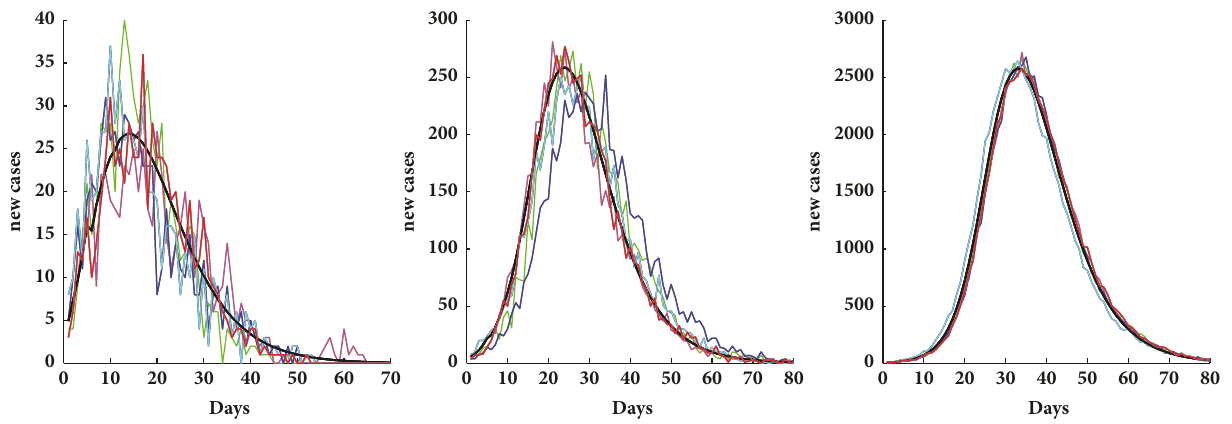
Figure 1: Three realizations are plotted for three values of 𝑁 ( 10 3 ,10 4 , 10 5 from left to right) with respect to the stochastic and its deterministic model. The rest parameters are 𝛽 = 2, 𝜆 = 12,𝑑 = 5, 𝑃 𝜏 = 1/5 (1 ≤ 𝜏 ≤ 5) , including the starting values, 𝑖(𝑡) = 0 (−4 ≤ 𝜏 ≤ −1),𝑖(0) = 15, 𝑆(−5) = 𝑁